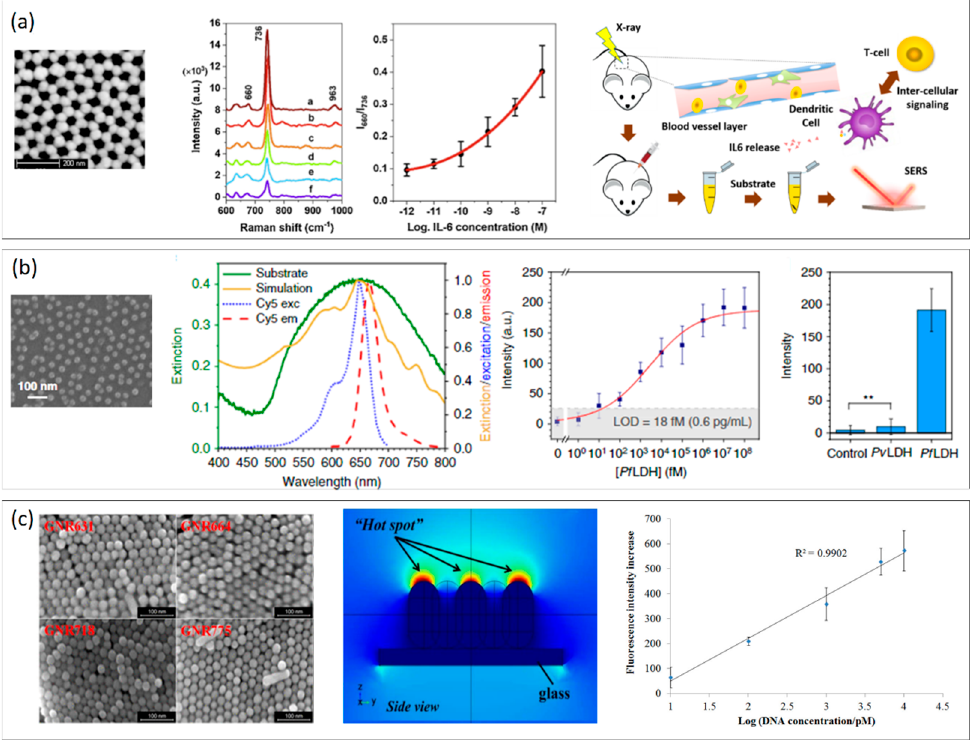
Figure 4. ( a ) From left to right: SEM image of a gold NP nanoarray for SERS detection of IL. The SERS signals prove the recognition of the target IL-6 in serum via corresponding changes of the output Raman intensity ratio (I660/I736) in the concentration range 10 − 12 –10 − 7 M. The proposed nanoarray is reported to give results comparable to ELISA tests in serum. Adapted with permission from Ref. [119]. Copyright (2021), Elsevier. ( b ) From left to right: SEM image of the AuNP hexag- onal array self-assembled on the top of a glass coverslip; experimental extinction spectrum of the substrate (green continuous line) and theoretical simulation of the optical response provided by the substrate morphology as measured by SEM (gold continuous line); on the same graph, the ex- citation and emission peaks of Cy5 (blue and red dashed lines) are reported; calibration curve (fluorescence intensity vs. PfLDH concentration in spiked human blood) of the immunoassay for